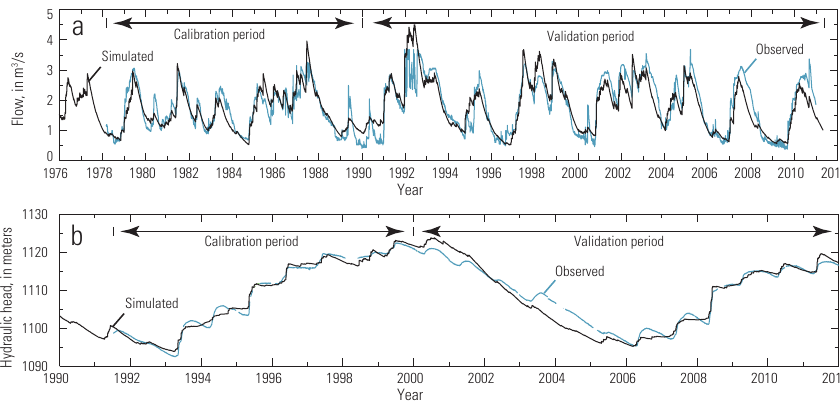
Fig. 3. Modeling results for (a) Barton Springs and (b) the Tilford well showing observed and simulated